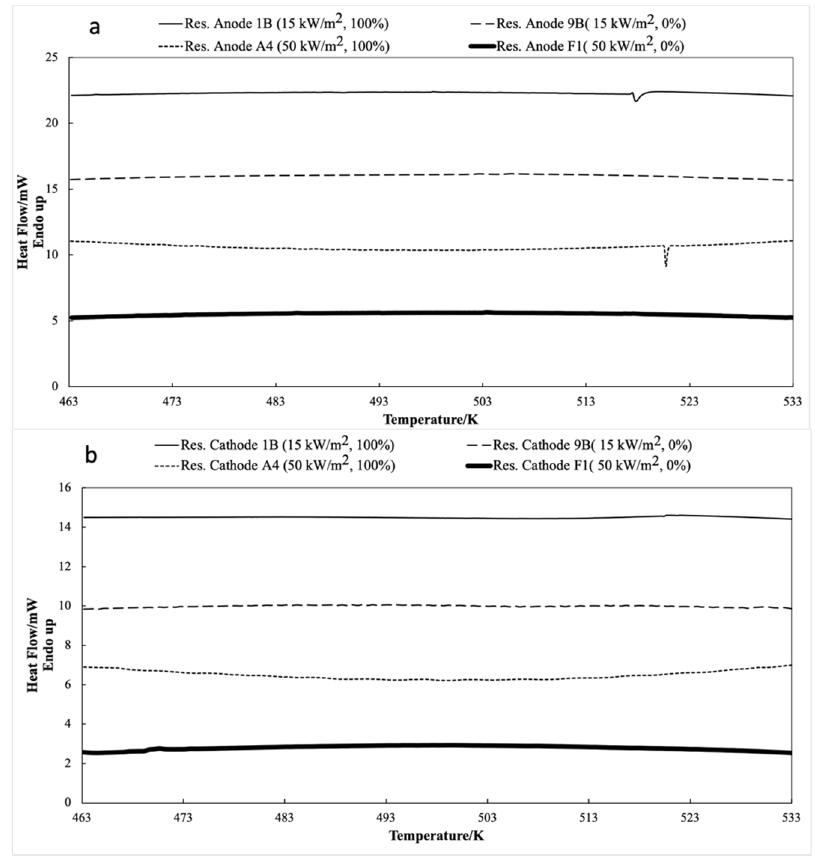
Figure 8. DSC curves of cell residues after thermal abuse tests: ( a ) anode ( b ) cathode.